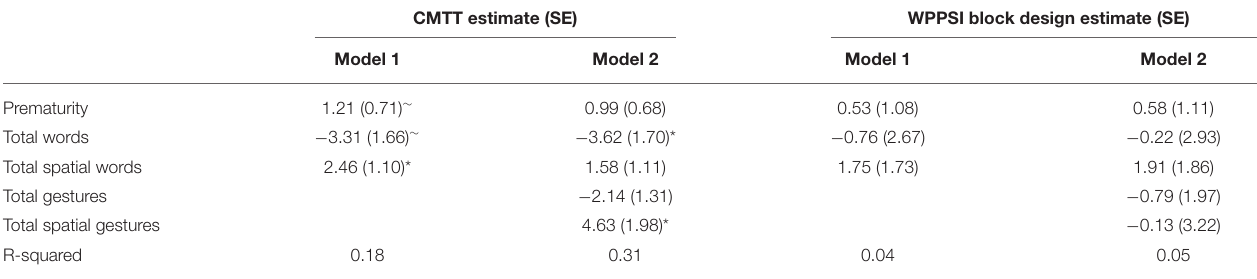
TABLE 4 | Hierarchical regressions predicting CMTT and WPPSI Block Design scores using prematurity, child words, spatial words, gestures, and spatial